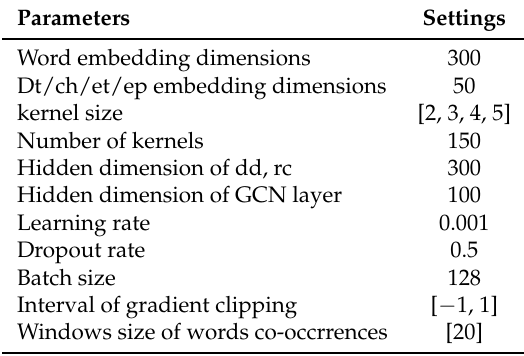
Table 2. Parameters settings of our model. dd and rc refer to the domain discriminator and relation classifier,